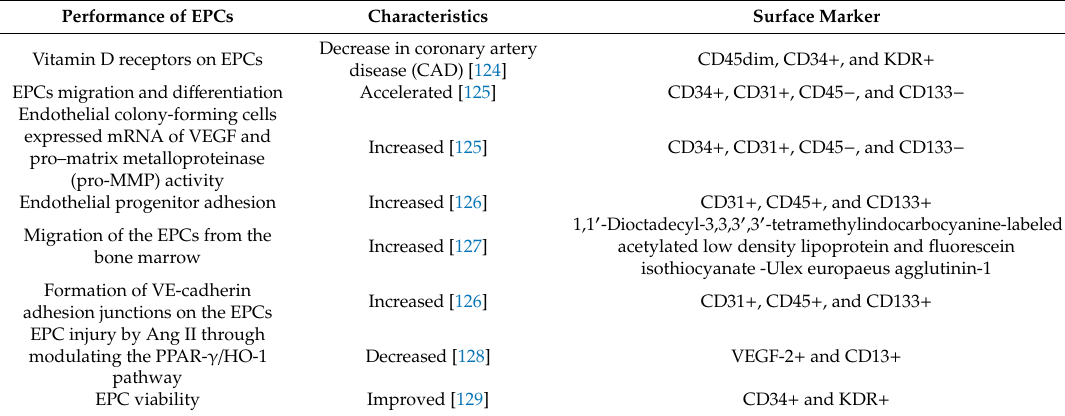
Table 1. The influence of vitamin D on EPCs in the development of vascular